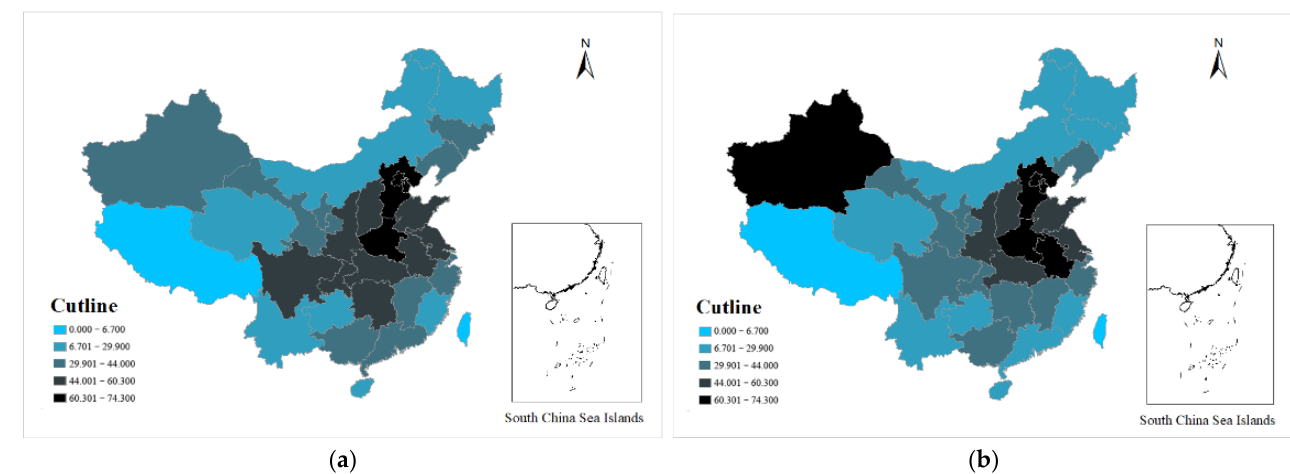
Figure 3. PM2.5 LISA cluster map. ( a ) 2003. ( b ) 2008.